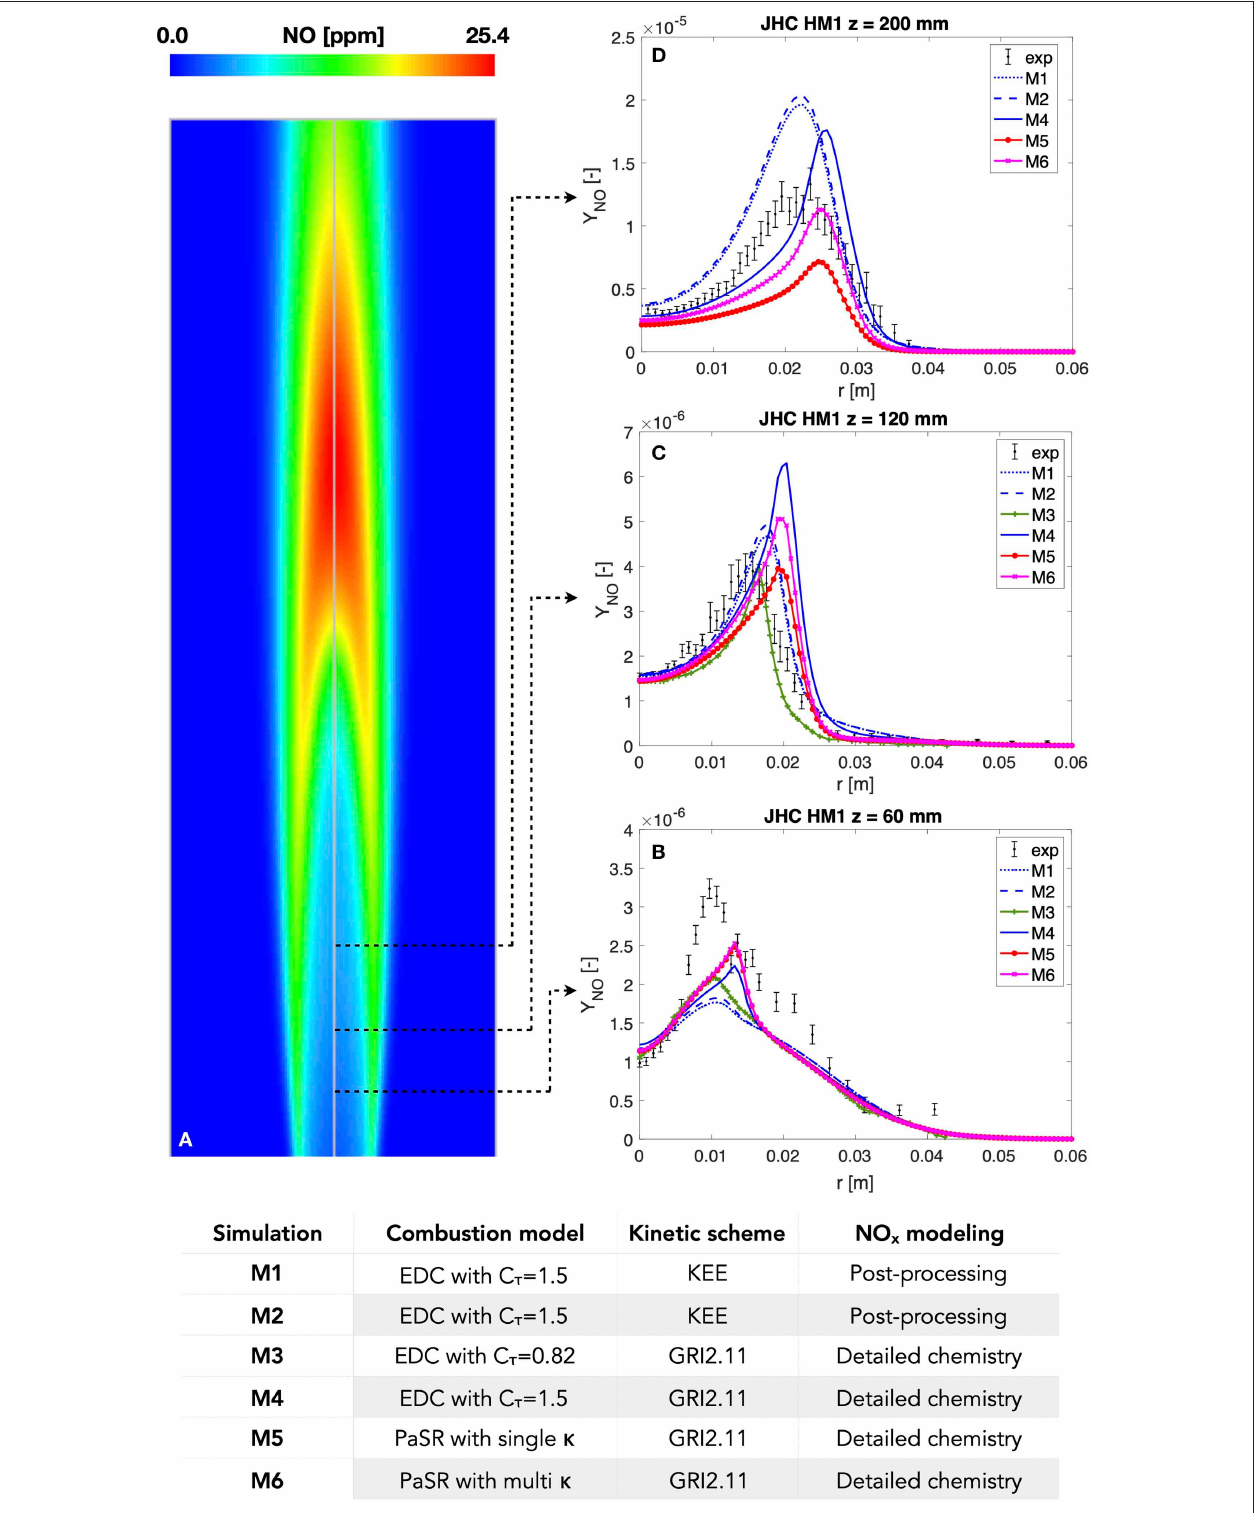
FIGURE 2 | (A) Contour plot of NO mass fraction in the Adelaide Jet in Hot Coflow (JHC) burner for the experimental case HM1 (jet Reynolds number Re = 10 k, = 0.03 in the coflow) (Dally et al., 2002). (B–D) Experimental and numerical radial profiles of NO mass fraction at axial coflow inlet temperature T cof = 1300 K, and Y O 2 locations z = 60/120/200 mm in the Adelaide JHC burner. The experimental profiles include both the mean values and the error bar with 99.5% confidence interval associated with a Student’s distribution for the true mean value. The relevant settings of the numerical simulations are reported in the explanatory table at the bottom.